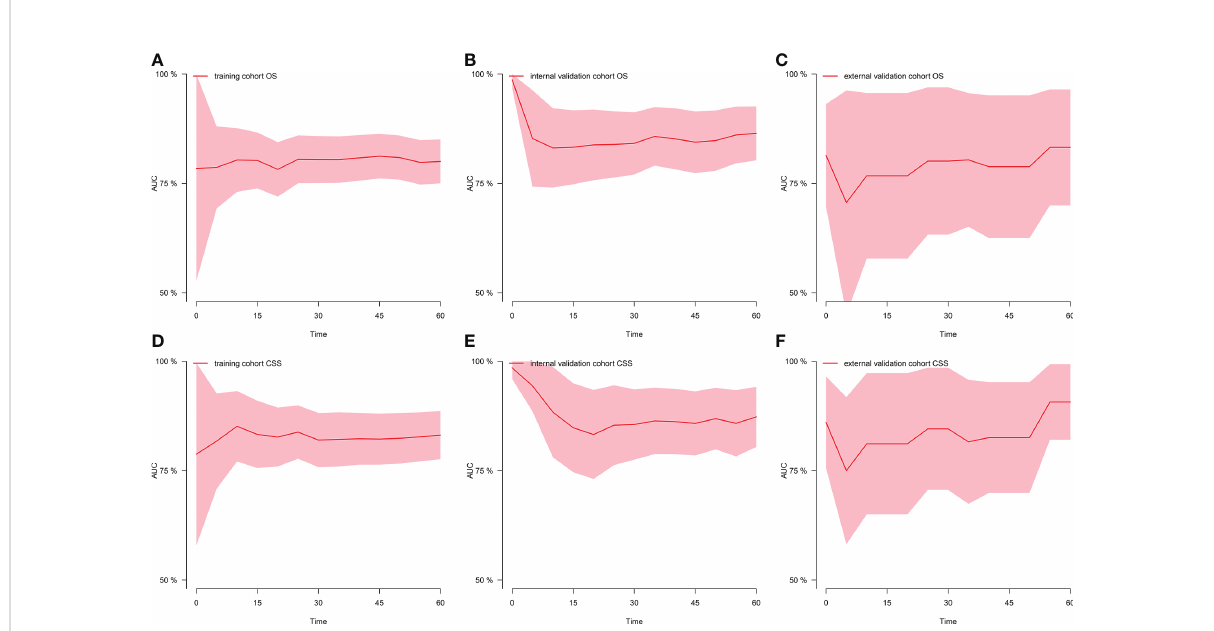
FIGURE 3 Time-dependent AUC at each time point. (A) Time-dependent AUC of OS in the training cohort; (B) Time-dependent AUC of OS in the internal validation cohort; (C) Time-dependent AUC of OS in the external validation cohort; (D) Time-dependent AUC of CSS in the training cohort; (E) Time-dependent AUC of CSS in the internal validation cohort; (F) Time-dependent AUC of CSS in the external validation cohort. AUC, the area under the curve value of the receiver operating characteristic; OS, overall survival; CSS, cancer-speci fi c